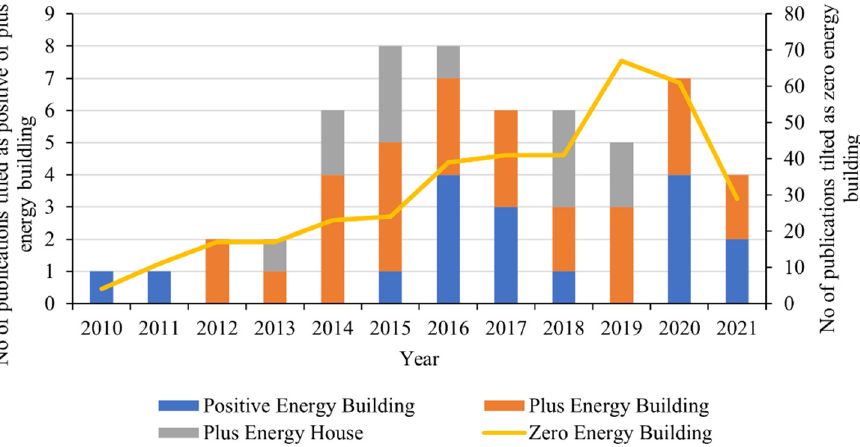
Figure 1. Comparison between the number of publications on zero and positive energy buildings by year.